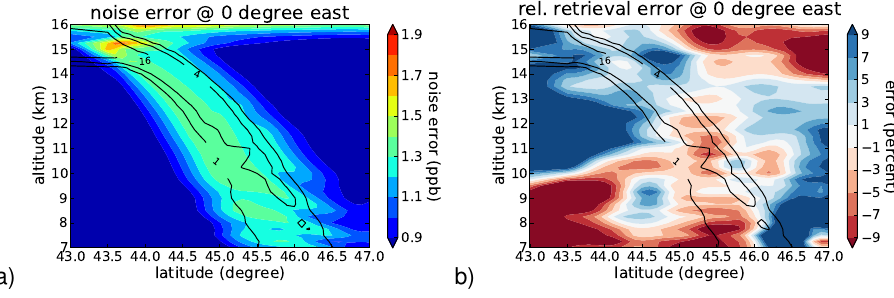
Fig. 6. The retrieval result for a linear flight track. Panel (a) shows the error induced by noise according to the linearised diagnostics. The relative error of the retrieval is plotted in panel (b) . The number of tangent points within the depicted volume elements is overlaid as a contour plot.